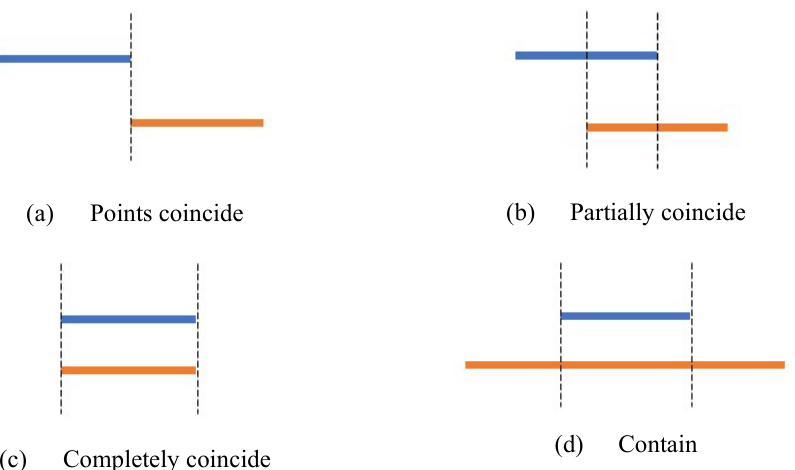
Figure 10. Several situations where time elements are adjacent (blue and orange line segments indicate two time periods).